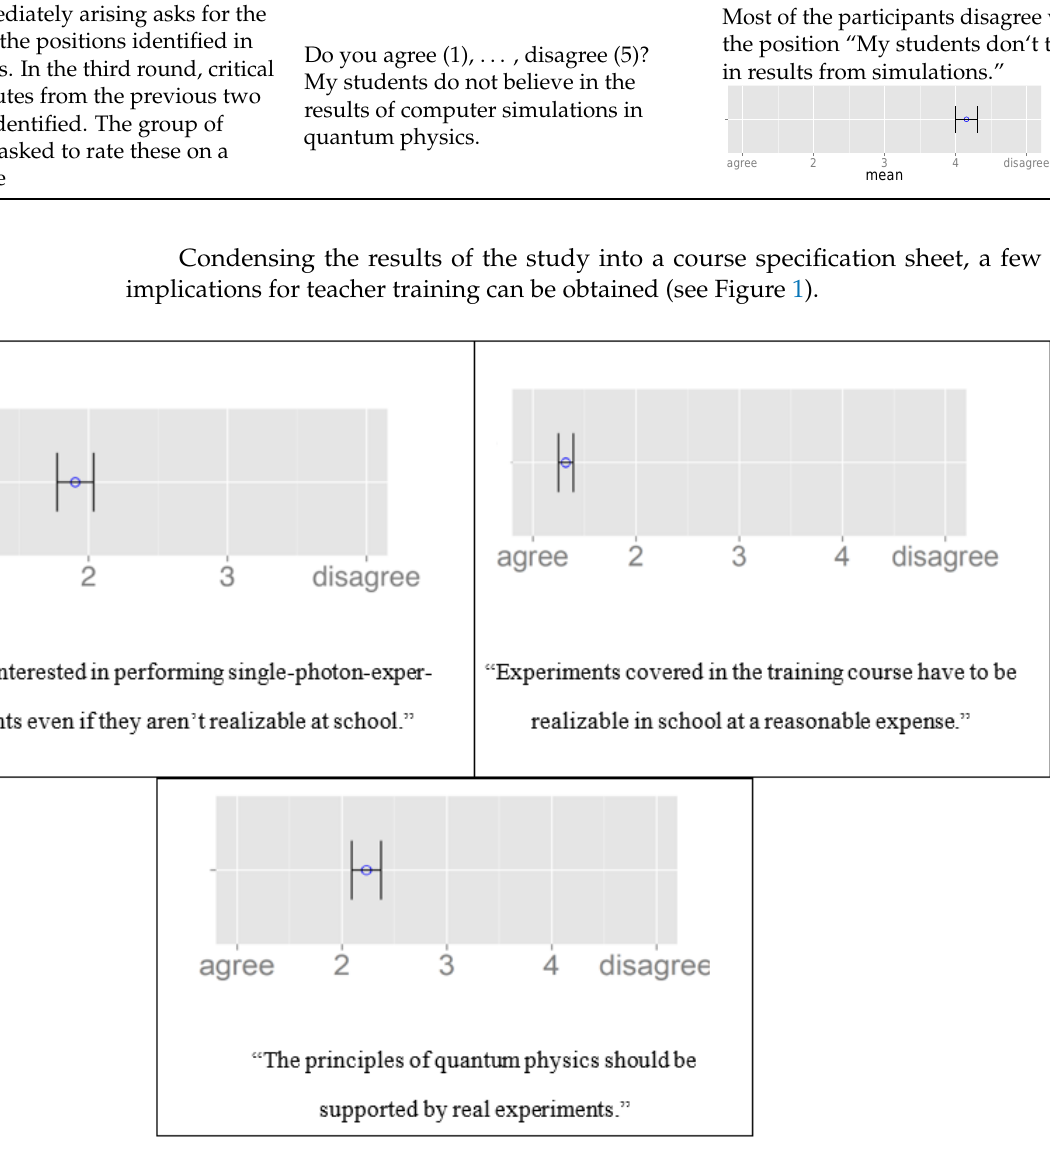
Figure 1. Teachers’ basic needs [43]. The mean value and the standard deviation of the particular ratings is shown.